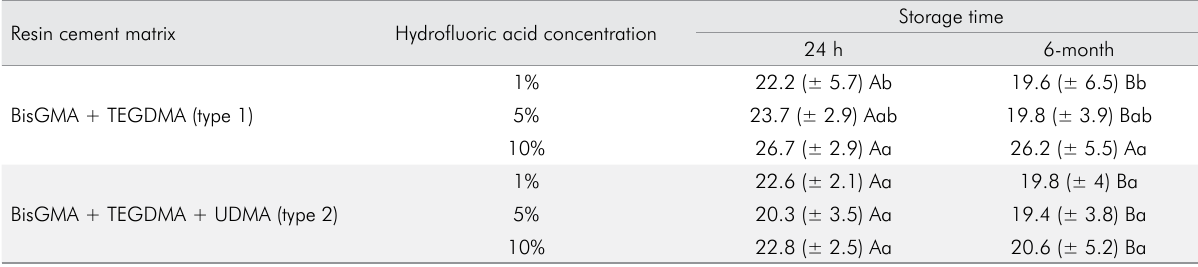
Table 2. Mean microtensile bond strength values (MPa) ± standard deviation of type 1 and 2 resin cements. Within each resin cement type, means followed by different letters (uppercase letters in line and lowercase letters in column) indicate significant statistical differences according to Tukey`s test (p < 0.05).